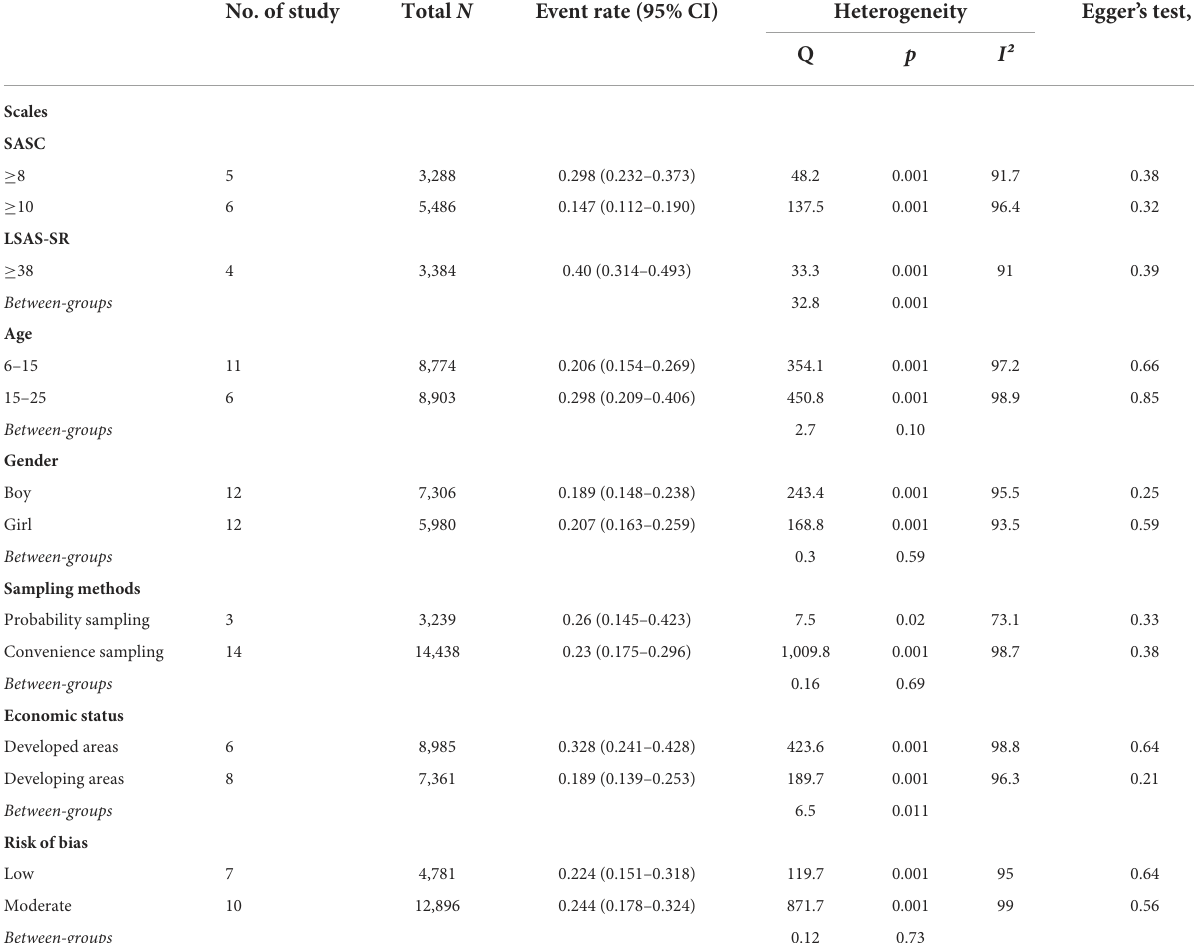
TABLE 4 Pooled event rates of social anxiety symptoms grouped by